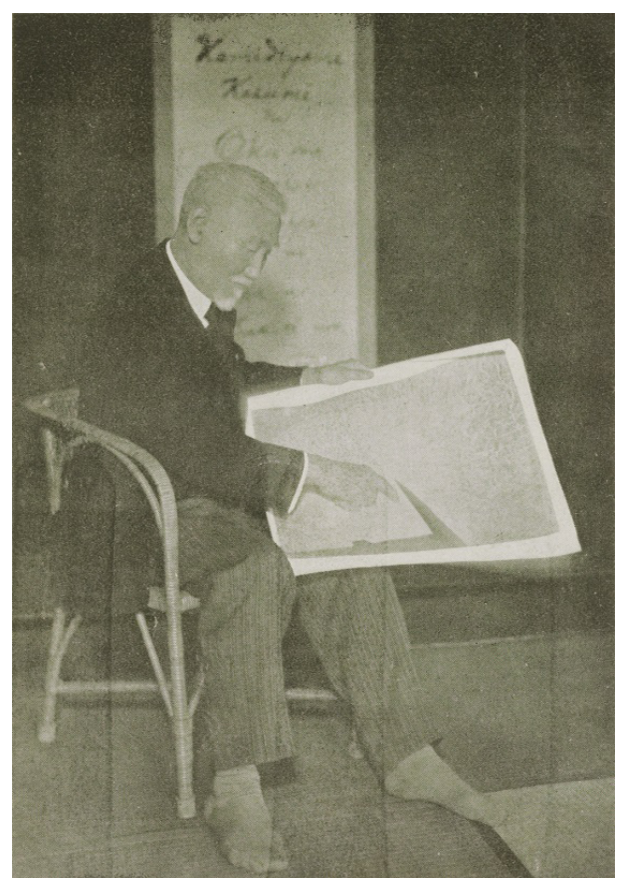
Figure 2. Aikitsu Tanakadate (1856–1952, Japan), the first Presi- dent of IAGA, who measured the Earth’s gravity and magnetic fields across Japan and established a latitude observatory in Mizusawa in